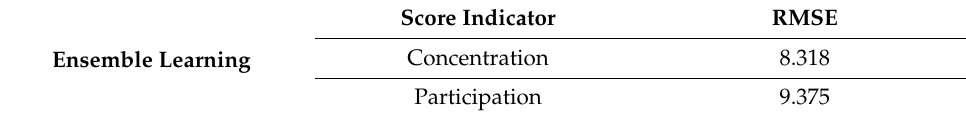
Table 9. Performance analysis for score indicators evaluated by the ensemble learning module.